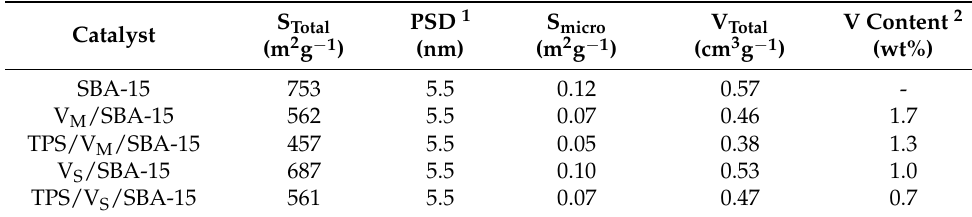
Table 1. Texture/structure characterization and vanadium incorporation efficiency.